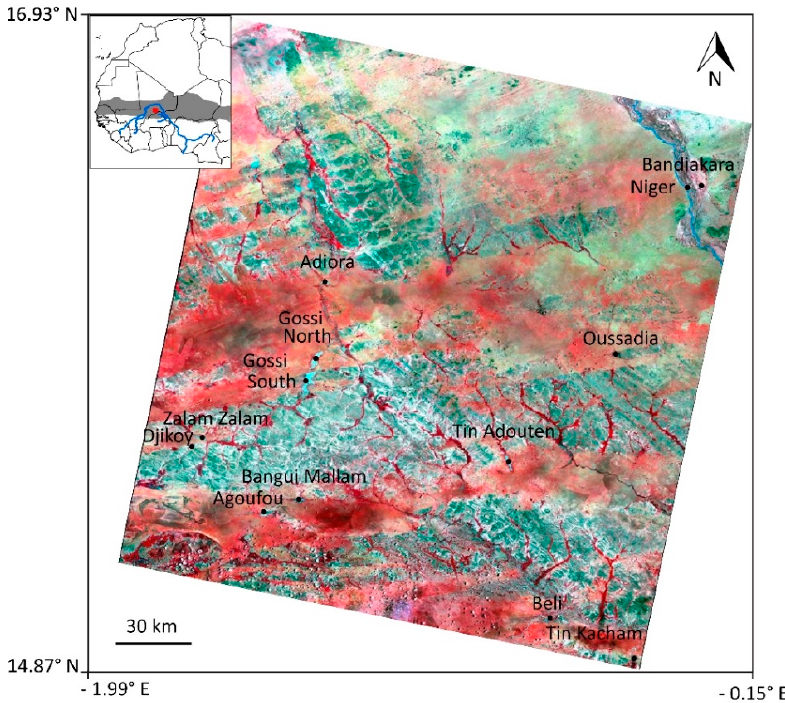
Figure 1. Study area. Sources: United States Geological Survey, Landsat 8 false color composite, 24 August 2013. The false color composite scheme is R = band 5 (near infrared band), G = band 4 (red band), B = band 3 (green band). The bluish color corresponds to bedrock and shallow soils on bedrock, the red color corresponds to herbaceous vegetation on deep sandy soil, and the light blue color to surface water. The gray color in the inset represents the Sahel, limited by isohyets 100 and 650 mm/year.